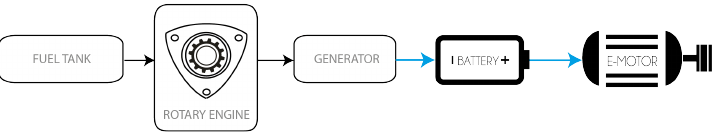
Figure 10. A diagram of the configuration of RE-ER.